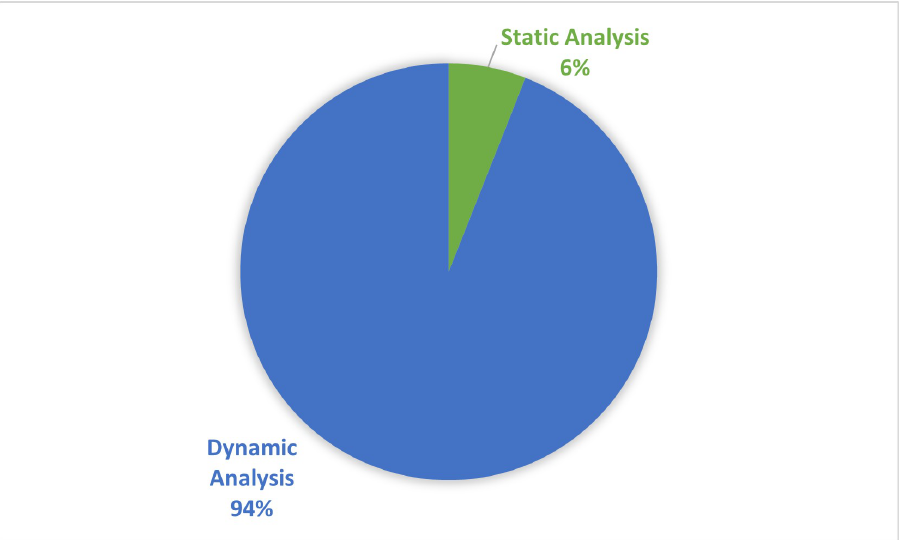
Figure 5. Execution Time in Percentage for Static and Dynamic